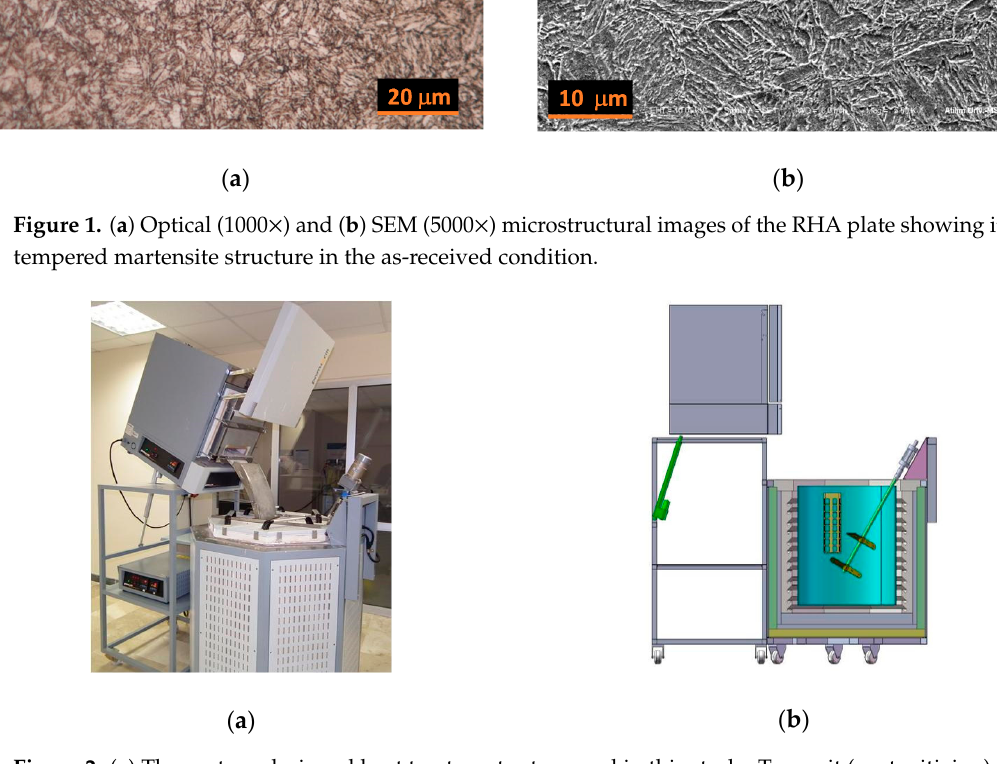
Figure 2. ( a ) The custom-designed heat treatment setup used in this study. Top unit (austenitizing) is tilted for quick transfer of the samples to the bottom unit (salt bath—isothermal treatment) through the guides. ( b ) Computer drawing of the setup showing the impeller and the sample basket in the salt bath. Table 2. Heat treatment conditions applied to the RHA plates. Sample Austenitization at 870 ◦ C for 60 min Isothermal treatment for 60 min at Tempering at 600 ◦ C for 120